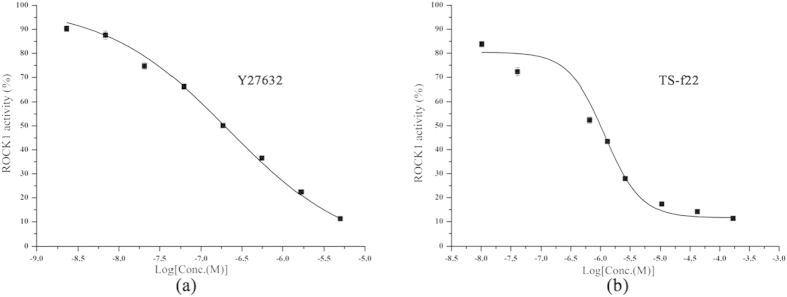
The concentration-dependent inhibition of ROCK1 activities for Y27632 and TS-f22.